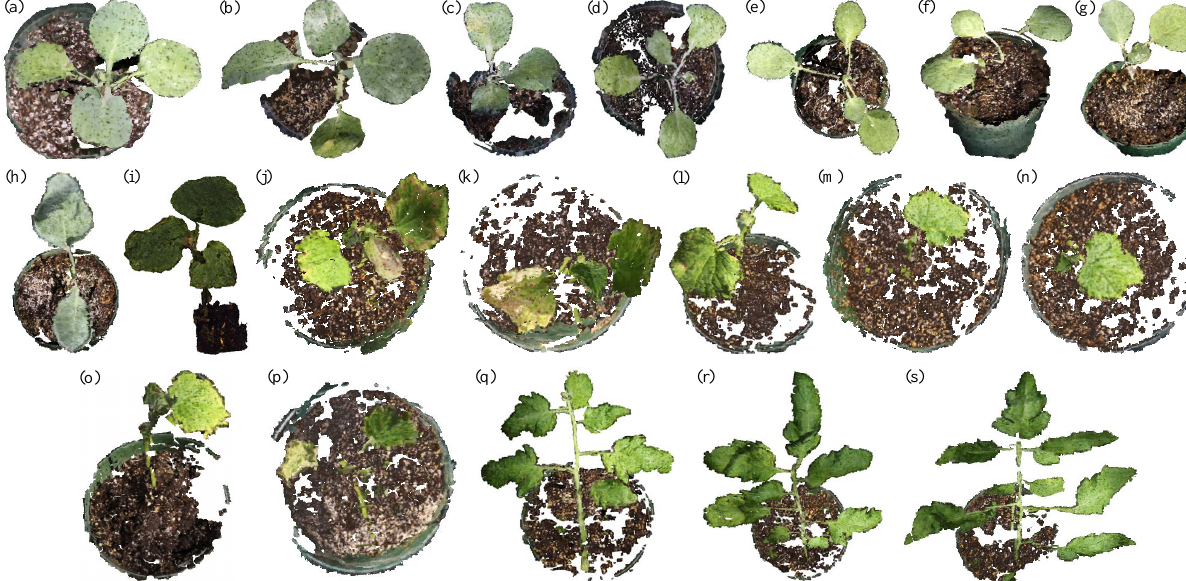
Figure 10. 3D model results of eight cabbage plants ( a – h ), eight cucumber plants ( i – p ) and three compound leaves from tomato plants ( q – s ). Table 1. List of the 19 plants used for the